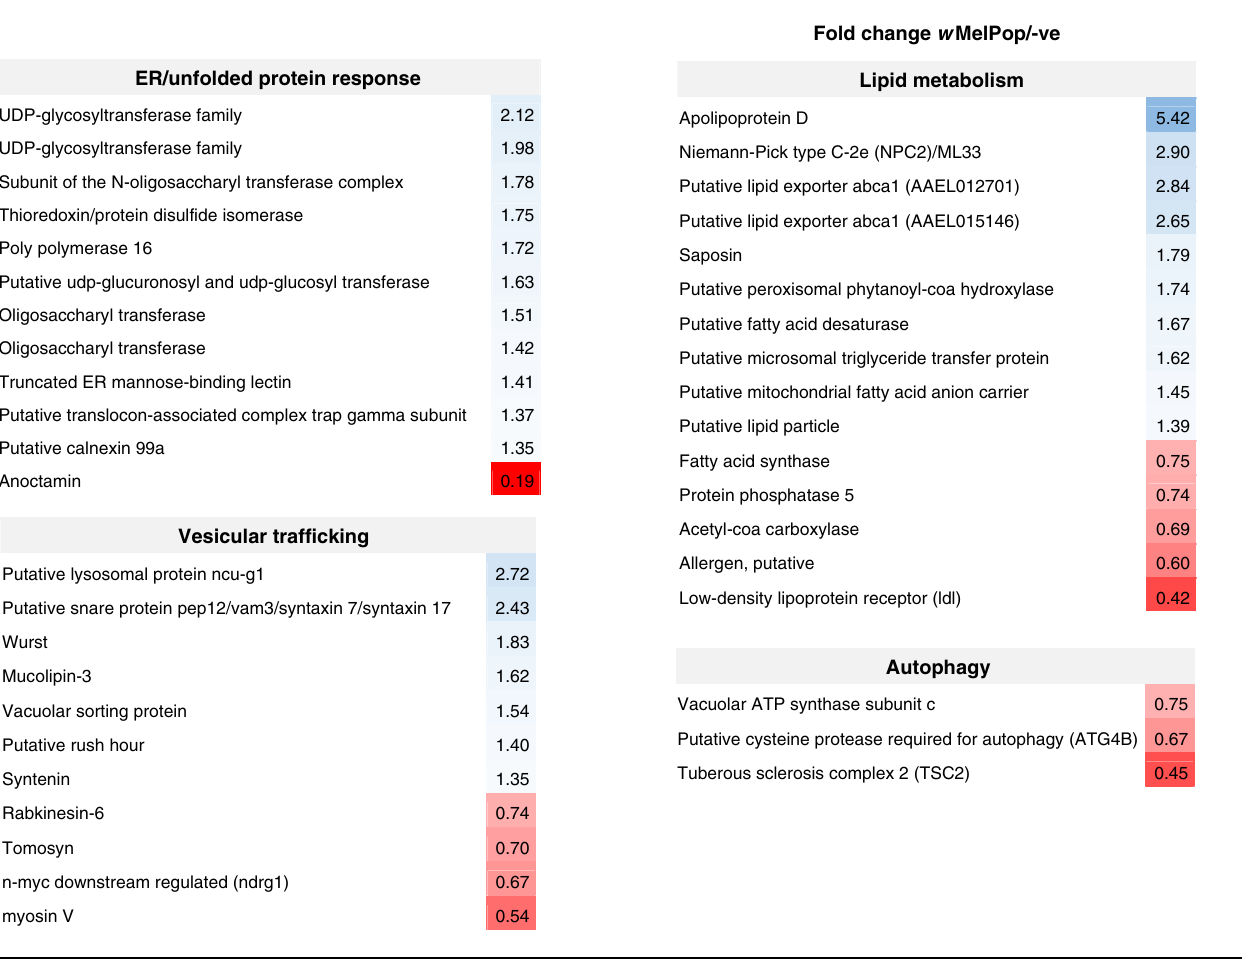
Table 1 Presence of Wolbachia causes differential expression of host proteins with roles in the unfolded protein response, vesicular traf fi cking, lipid metabolism and autophagy